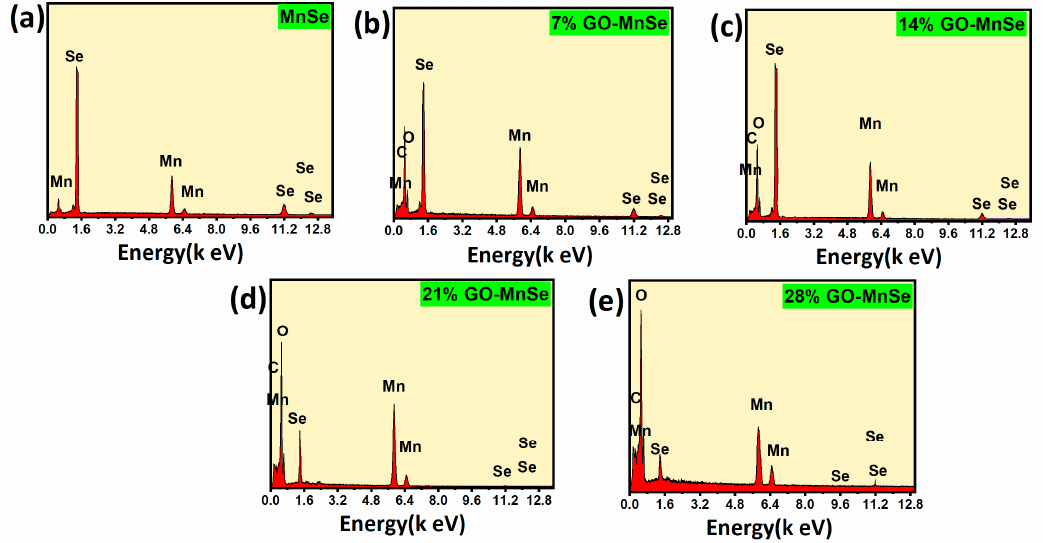
Figure 4. ( a ) EDX spectra of MnSe, ( b ) 7% GO-MnSe, ( c ) 14% GO-MnS, ( d ) 21% GO-MnSe, and ( e ) 28% GO-MnSe.